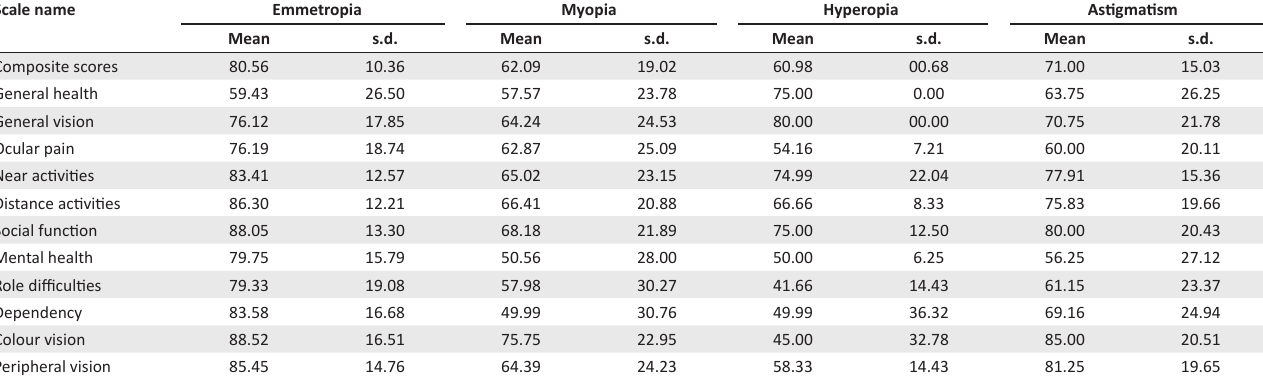
TABLE 6: The mean and standard deviation (s.d.) of subscores of the items on the National Eye Institute Quality of Life Questionnaire-25 according to refractive